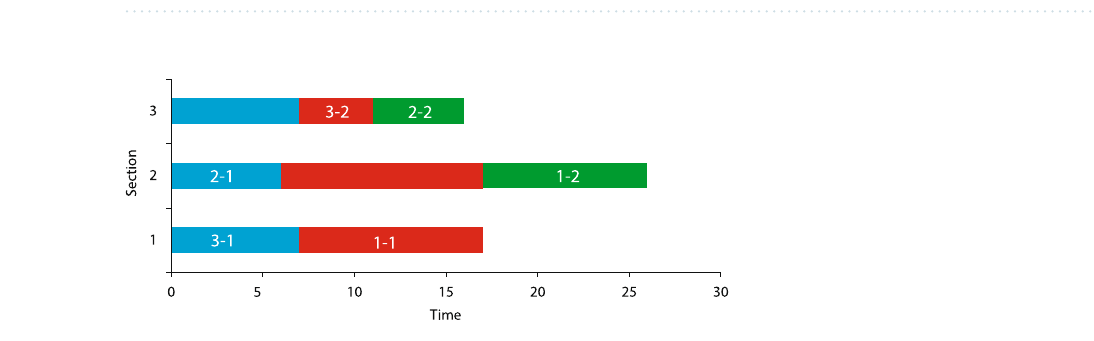
Table 5. Parameters of the problem three patients and three sections. It is assumed that the time of the patient’s arrival occurred at time 0. Of the three patients, patient 3 entered the emergency patient’s entrance. That is, patient 3 has a higher priority (Fairness). It is also assumed that there is only one person in each department to serve and provide services. Patients’ weight or preference are considered 2, 3, and 5, respectively. The rate of decrease in patient satisfaction due to increased hospital stay is set at 0.2.